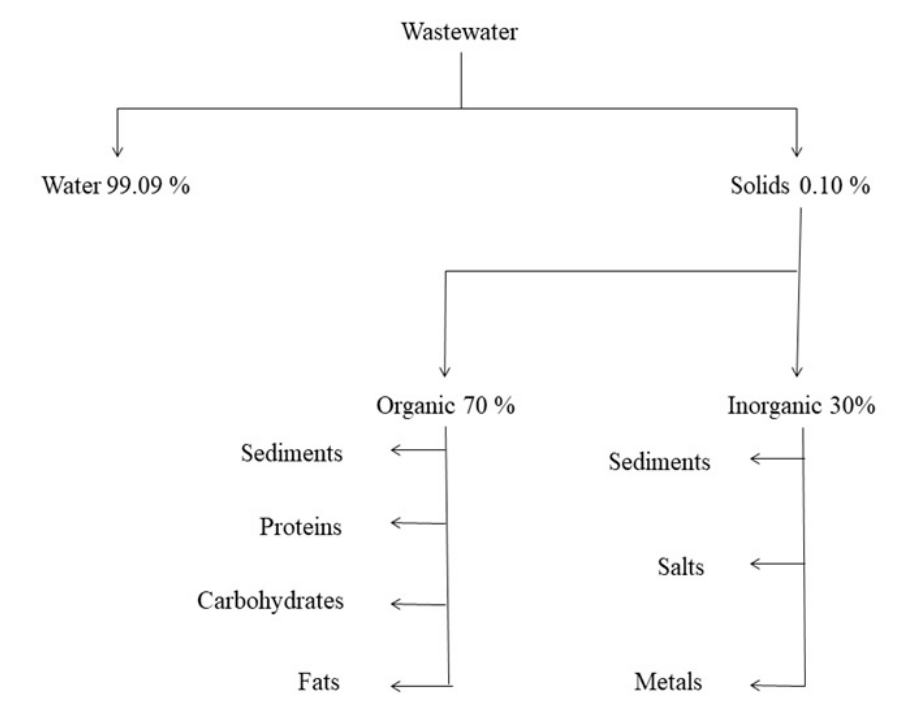
Figure 2. Typical composition of sewage water.